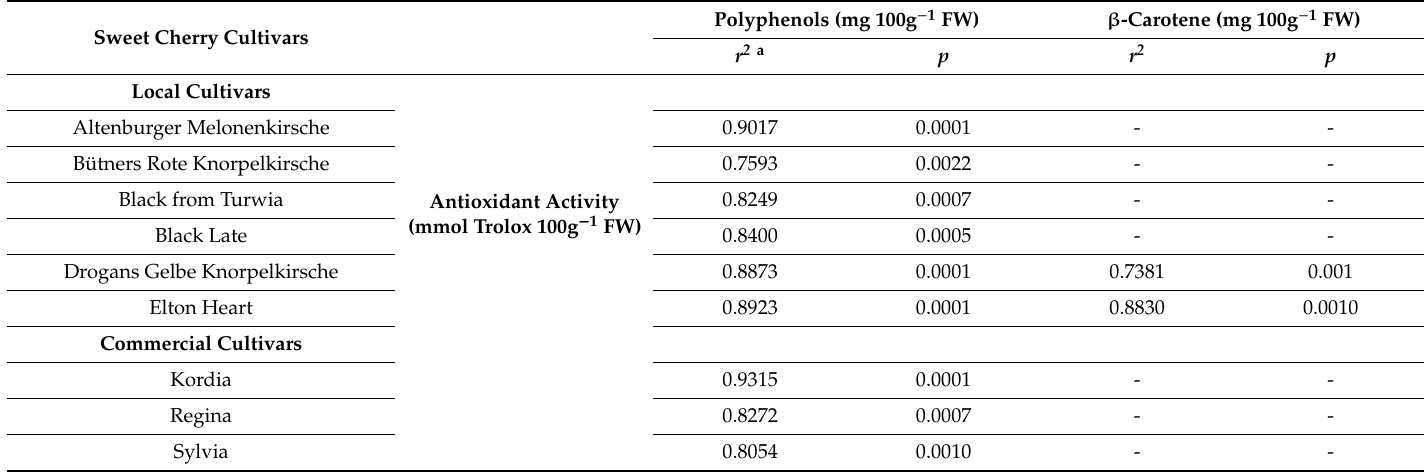
Table 7. Correlations between antioxidant activity and polyphenols and β -carotene concentrations in fruits of local and commercial sweet cherry cultivars harvested in 2012 and